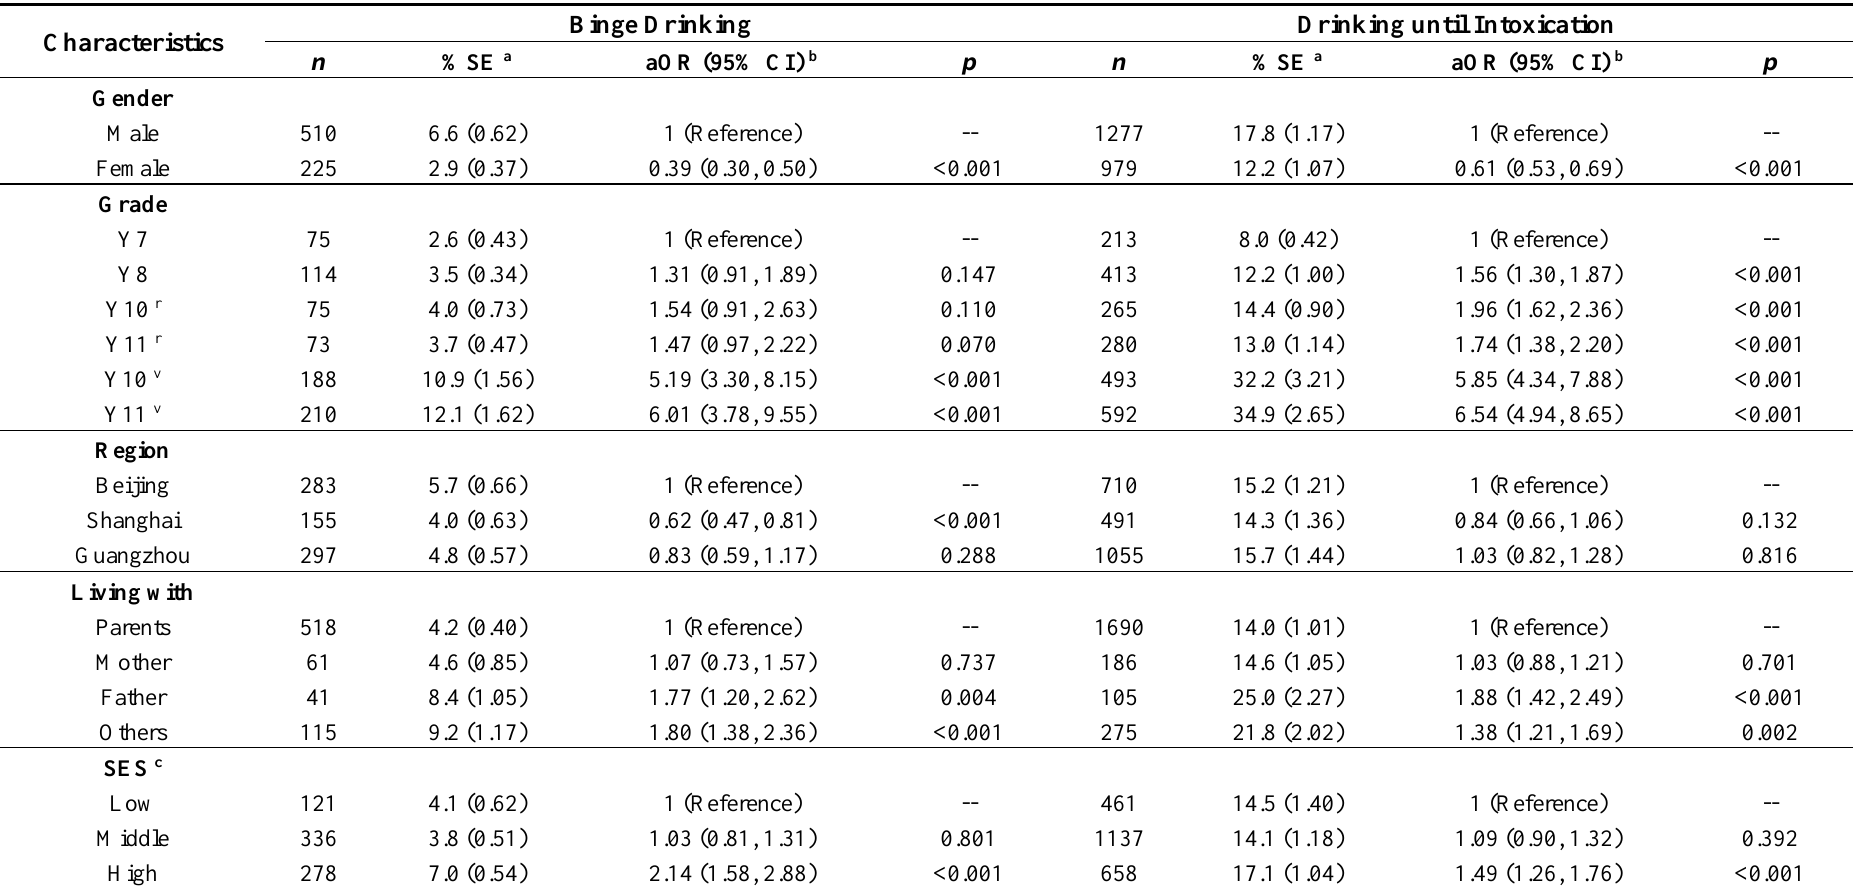
Table 5. Prevalence, adjusted odds ratios, and 95% confidence interval of binge drinking and drinking until intoxication based on socio-demographic